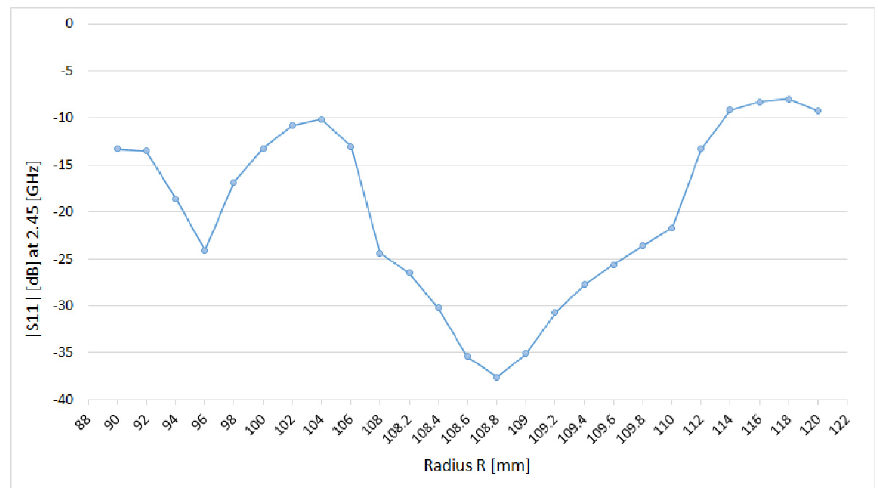
Figure 3. Variation in |S11| parameter (dB) calculated at the operating frequency of 2.45 (GHz) as function of the radius R of the circumscribed circle of the hexagonal applicator.